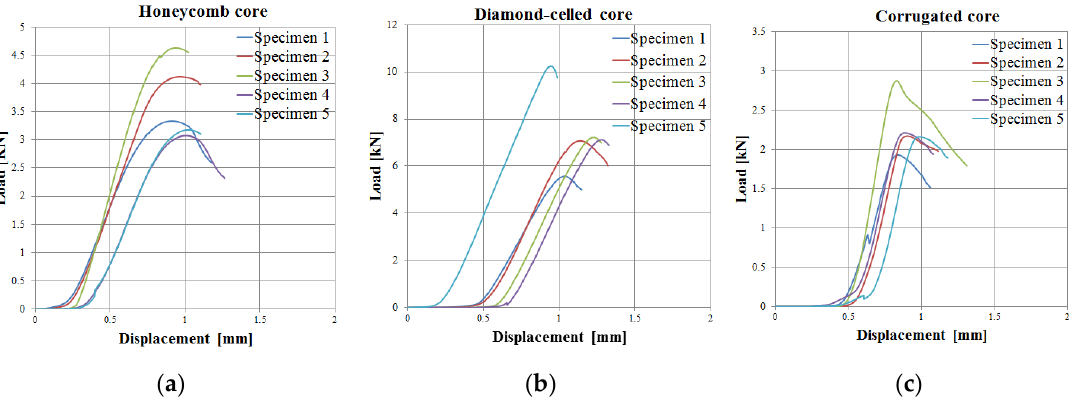
Figure 8. Load–displacement curves obtained from the compressive test of the sandwich specimens: ( a ) honeycomb core; ( b ) diamond-cell core; ( c ) corrugated core.